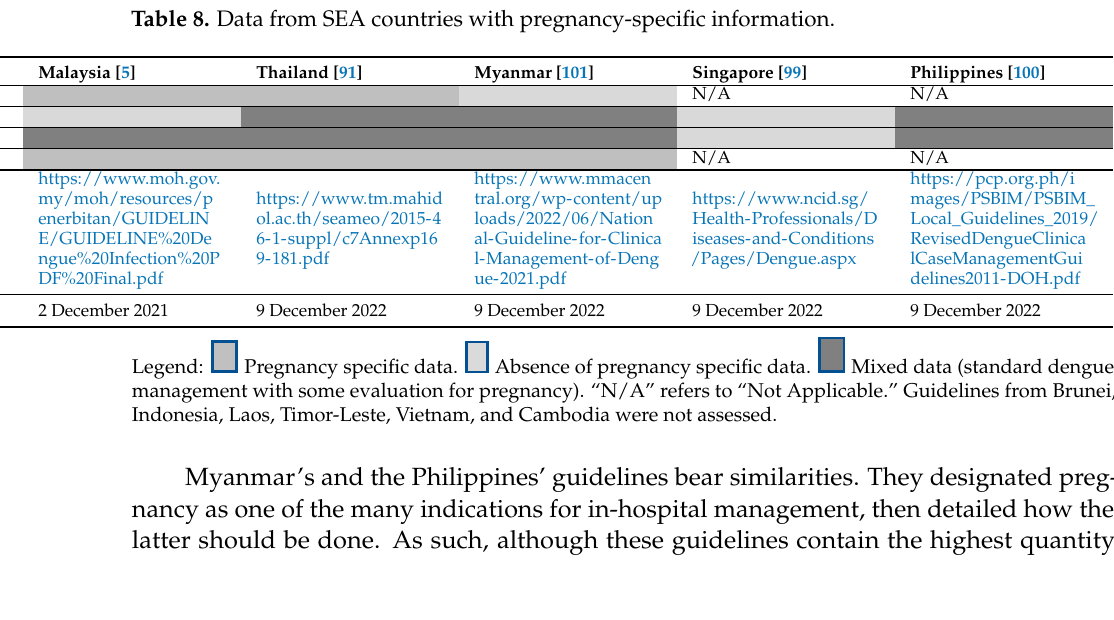
Table 8. Data from SEA countries with pregnancy-specific information.